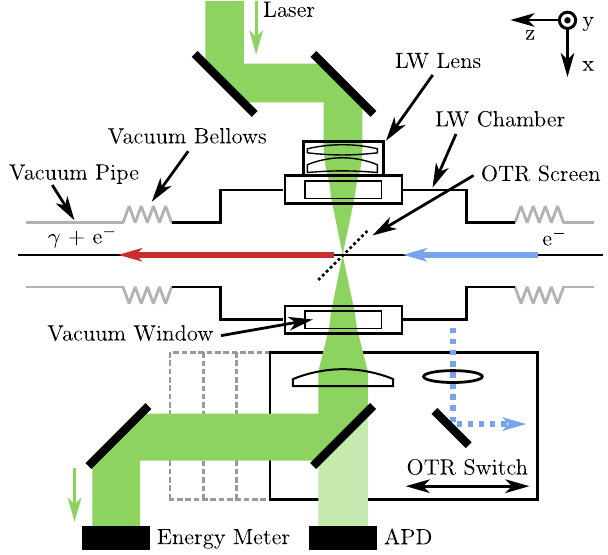
FIG. 7. Schematic of the laserwire (LW) interaction point in plain view showing the lens and vacuum windows attached to the vacuum chamber, the laser beam path (green), and post-LWIP optical switch for the OTR. The laser beam enters at the top of the diagram and is absorbed in the energy meter. The APD is used for timing